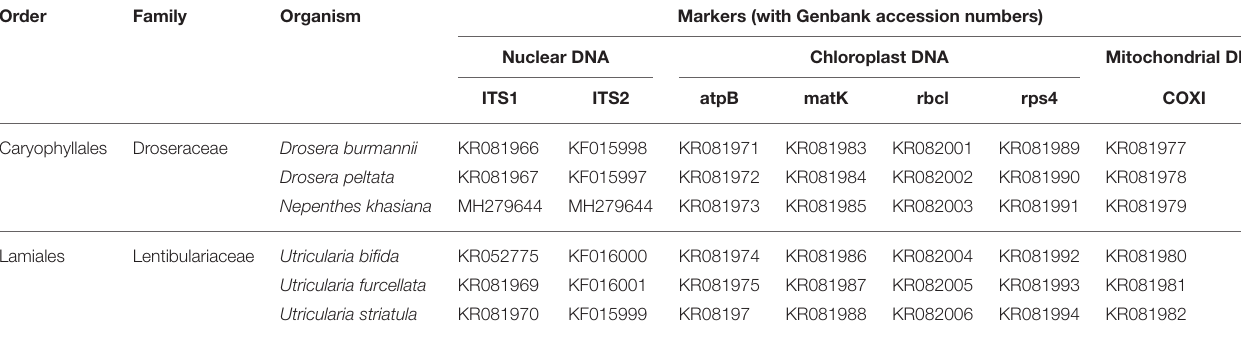
TABLE 2 | Genbank accessions of nuclear, chloroplast and mitochondrial DNA markers for the carnivorous plant samples undertaken in the study from Meghalaya, India. Order